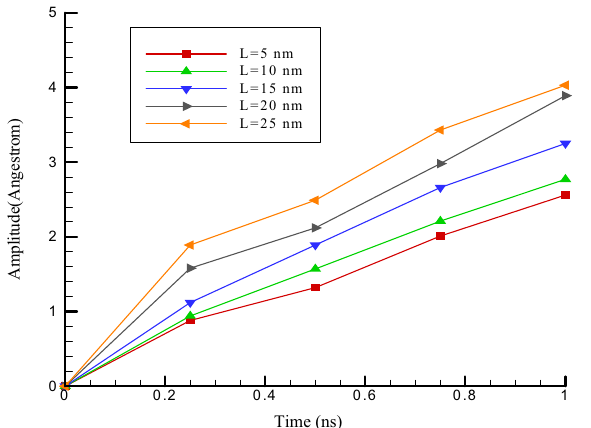
Figure 5. Oscillation amplitude of carbon nanotubes versus length of carbon nanotubes (7 and 7) in different time steps.